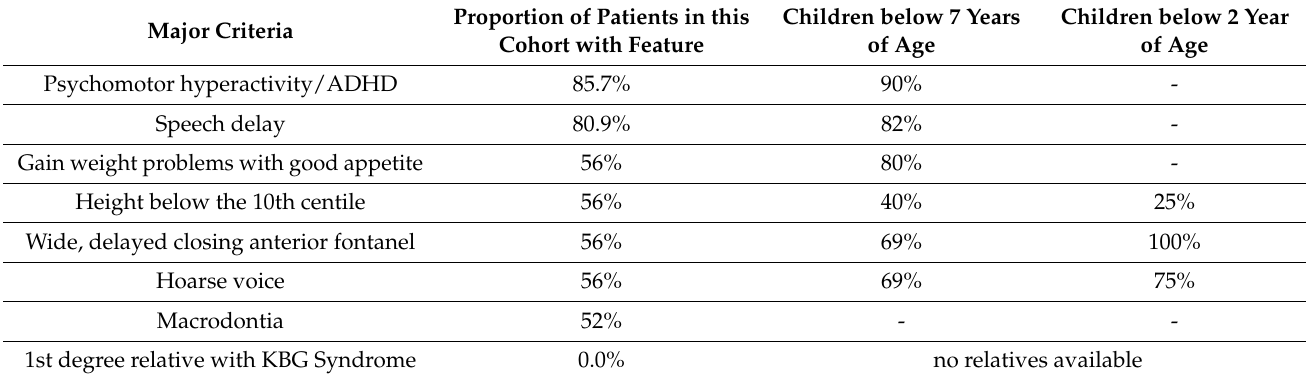
Table 6. Proposal of diagnostic aid in KBG syndrome (based on Low et